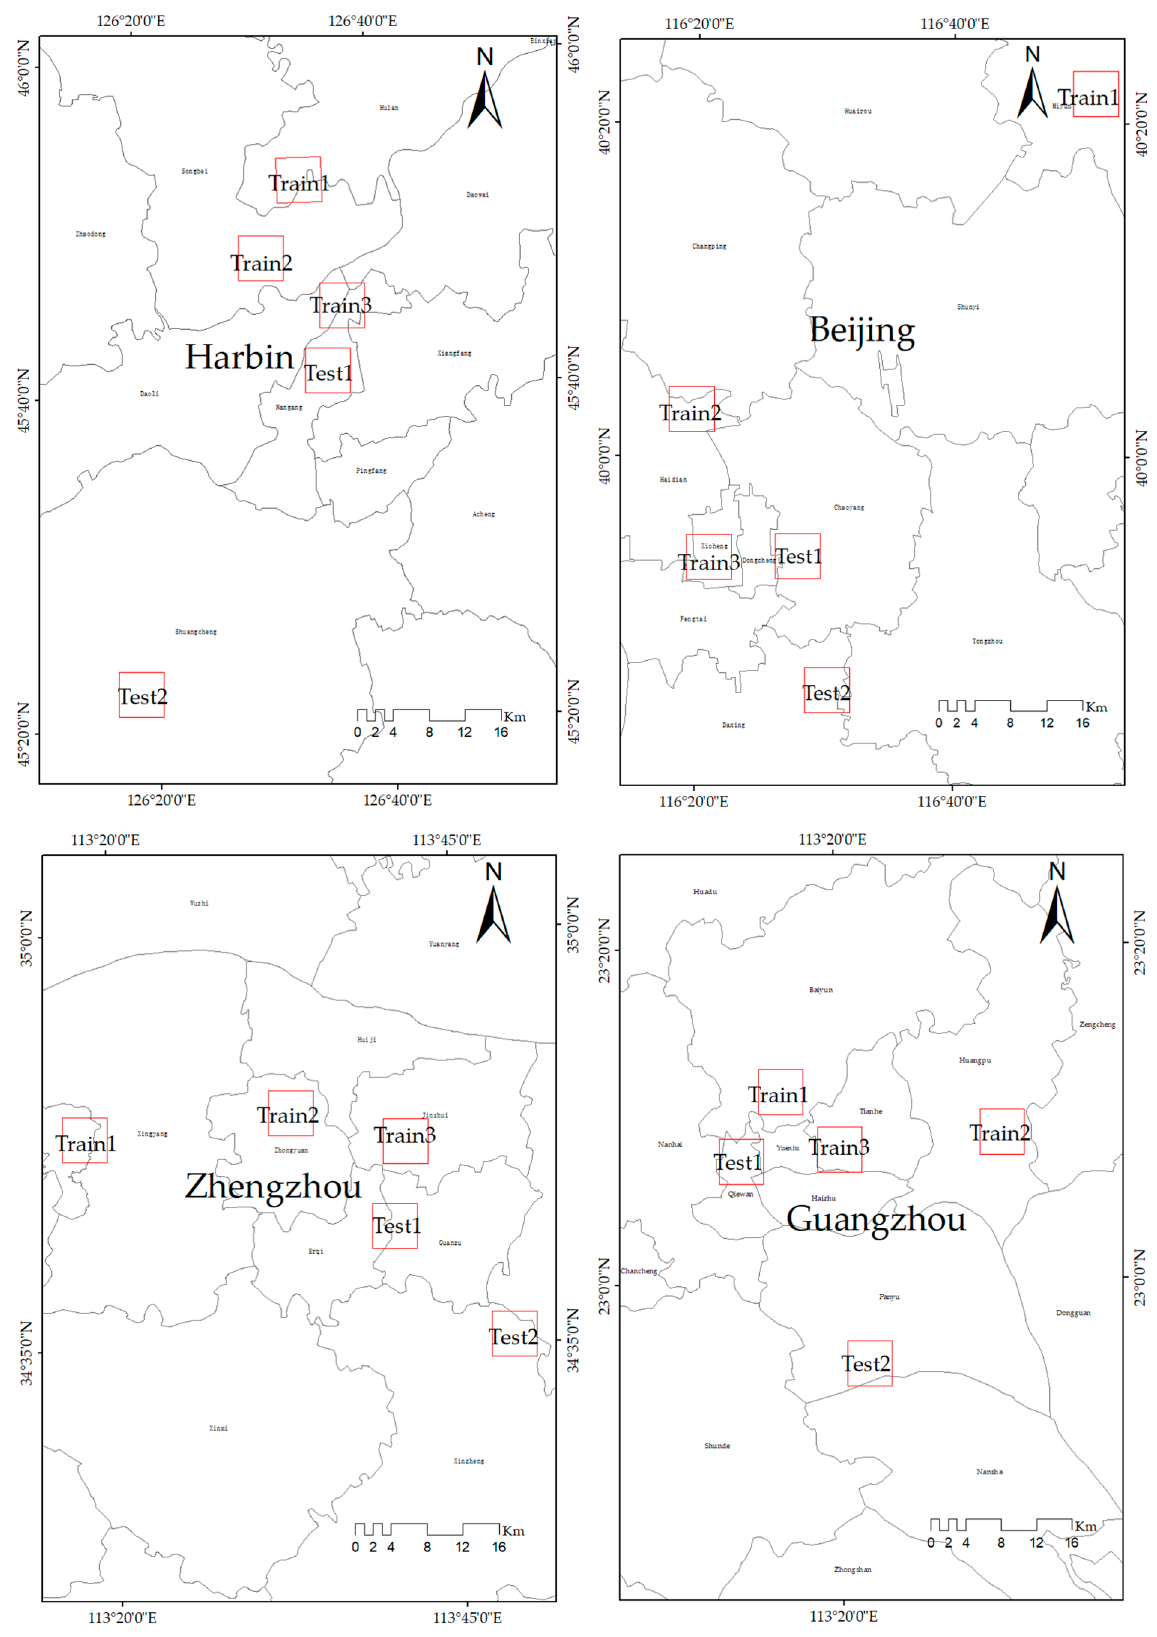
Figure 1. Illustrations of five regions selected in our study and five sample areas in each region used for sample collection (Red boxes show the selected sample areas).